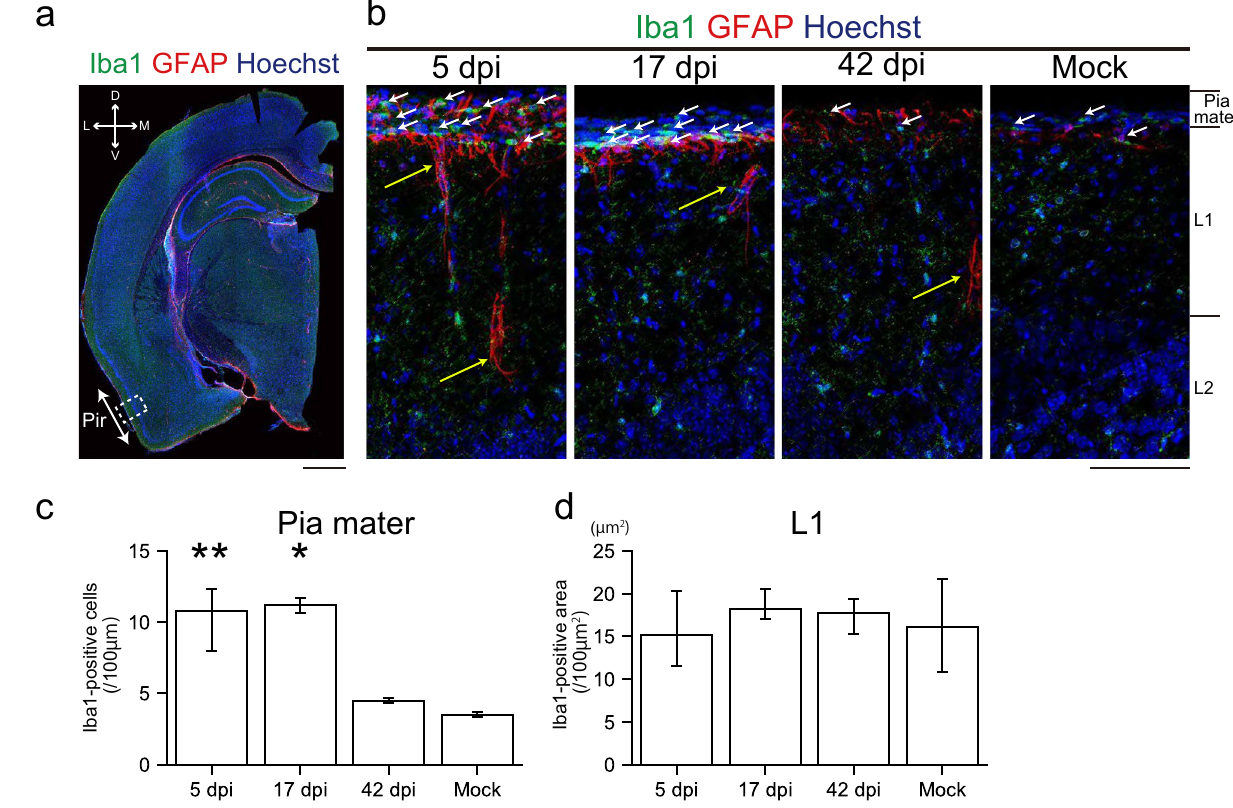
Figure 8. Glial activities in the piriform cortex (PC) due to SARS-CoV-2 infection. (a) Representative coronal image of the cerebral hemisphere stained with ionized calcium binding adaptor molecule 1 (Iba1), GFAP, and Hoechst. The white arrow indicates the PC and the white dashed square is a region of interest in the study. Scale bar, 1 mm. (b) Representative images of the layers of pia mater, layer 1 (L1), and layer 2 (L2) stained with Iba1, GFAP, and Hoechst at 5, 17, and 42 dpi and mock. White and yellow arrows show Iba1- and GFAP-positive cells, respectively. Scale bar, 100 μm. (c) Quantitative analysis of Iba1-positive cells in the pia mater. (n = 3,